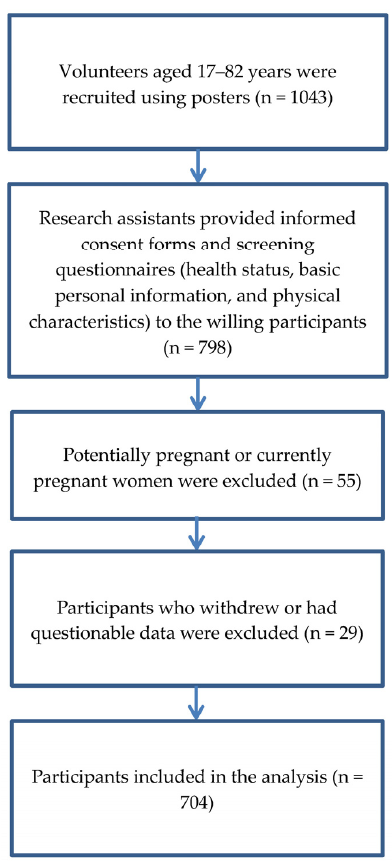
Figure 1. Flow chart of the study participants included in the analysis.